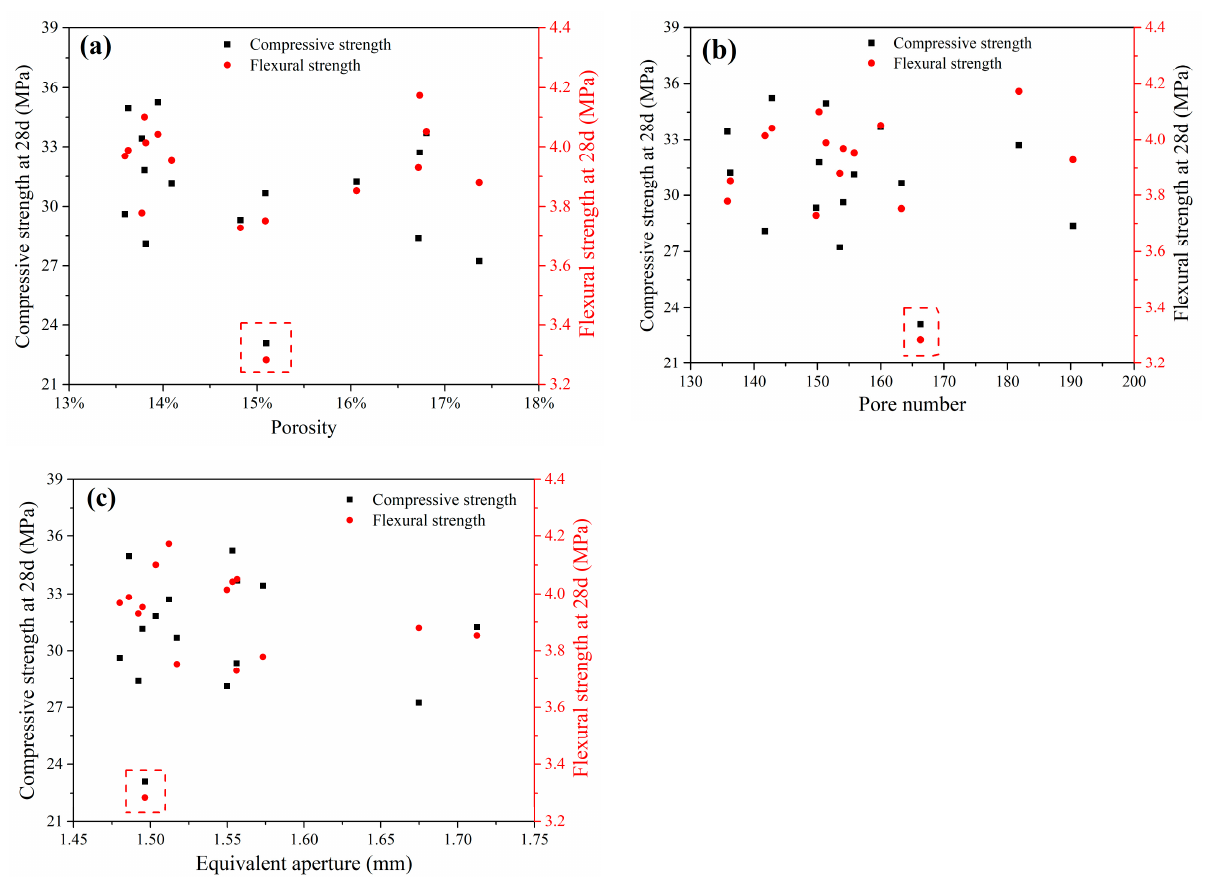
Figure 11. The relationship between strength and pore characteristics; ( a ) porosity, ( b ) pore number, ( c ) equivalent aperture.